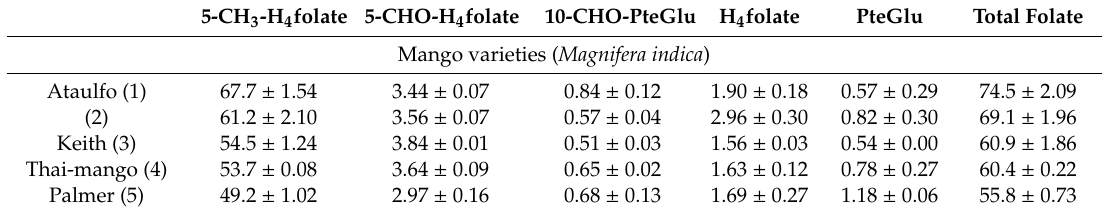
Table 1. Total folate content ( µ g / 100 g, calculated as PteGlu) in mangos.